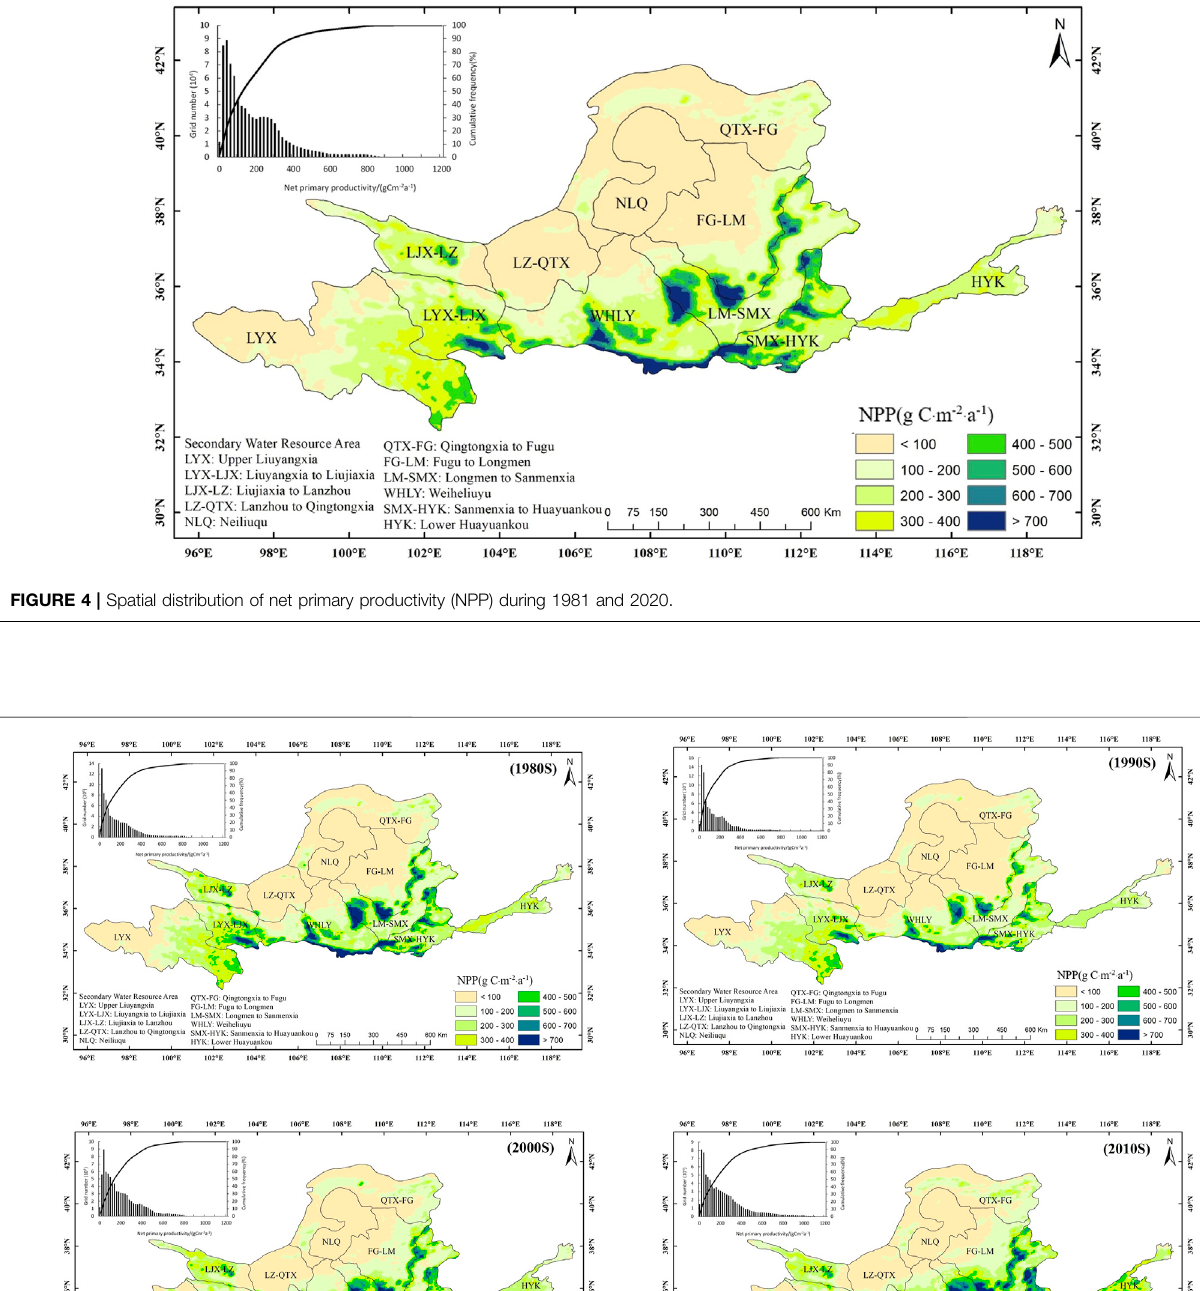
Frontiers in Environmental Science |